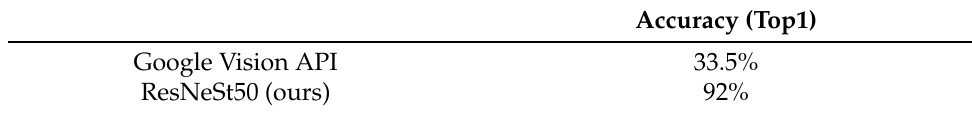
Table 5. The results of precision and